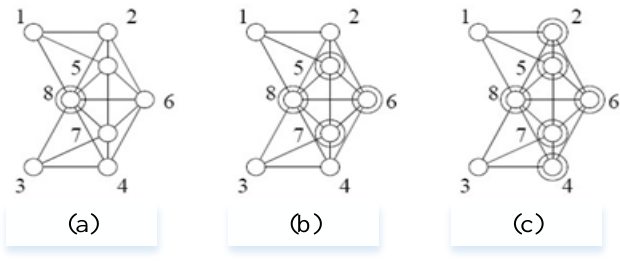
Figure 4. The examples of K -CDS: ( a ) K = 1; ( b ) K = 2; ( c ) K = 3.